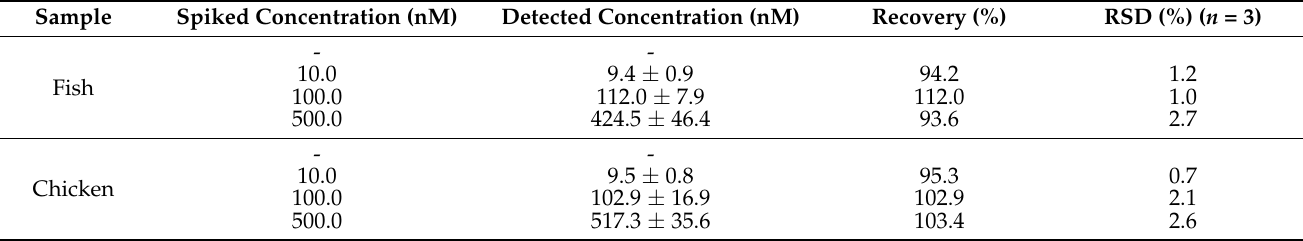
Table 2. Results of detection of enrofloxacin in fish and chicken meat using the developed ratiometric SERS